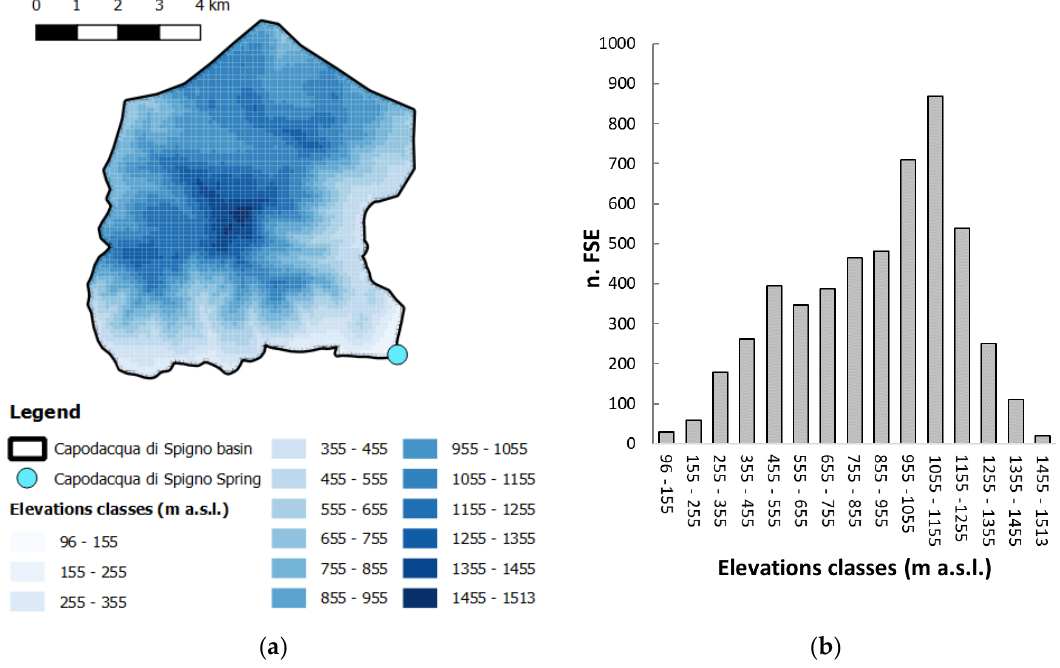
Figure 7. ( a ) Elevations classes distribution of Capodacqua di Spigno Spring basin; ( b ) number of finite squared elements (FSE) of 100 × 100 m for each elevation class.